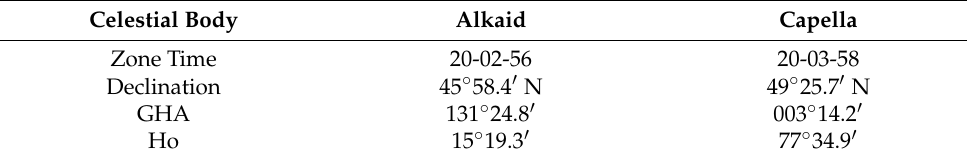
Table 2. The observation data for solving the celestial positioning in Example 1.